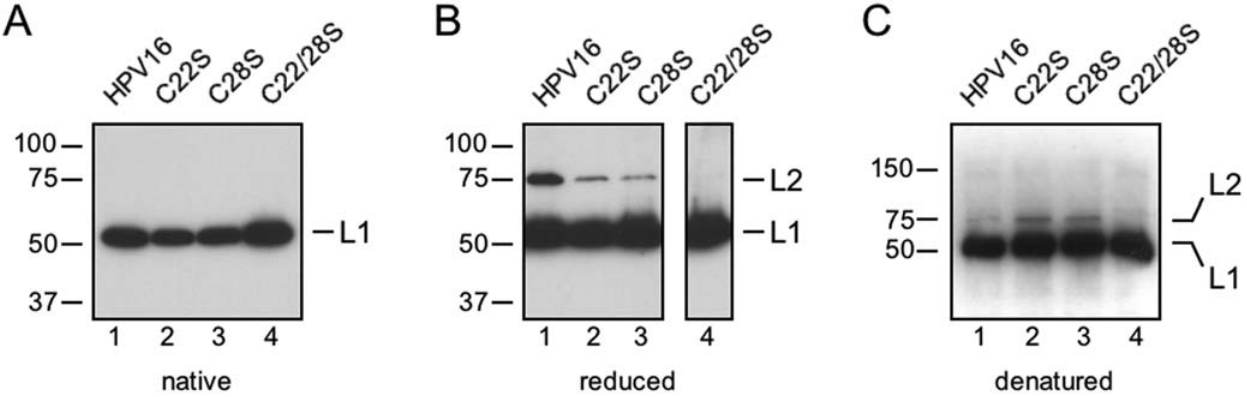
Figure 3. Thiol biotinylation assay of HPV16 L2 cysteine mutants. (A) Lack of L2 biotinylation by BMCC-biotin of normal and mutant virions in their native state suggest that L2 cysteines are either buried and inaccessible to BMCC-biotin or bound up and not present as free thiols. (B) L2 cysteines become accessible and are biotinylated in DTT-reduced virions. (C) Denaturation of virions by SDS results in L2 biotinylation of C22S and C28S single mutants only (lanes 2,3), indicative of free but buried cysteines in these mutants. Lack of L2 biotinylation in denatured wild type virions implies that although the cysteines are exposed, they are bound as an intramolecular disulfide, becoming available for modification in the single mutants